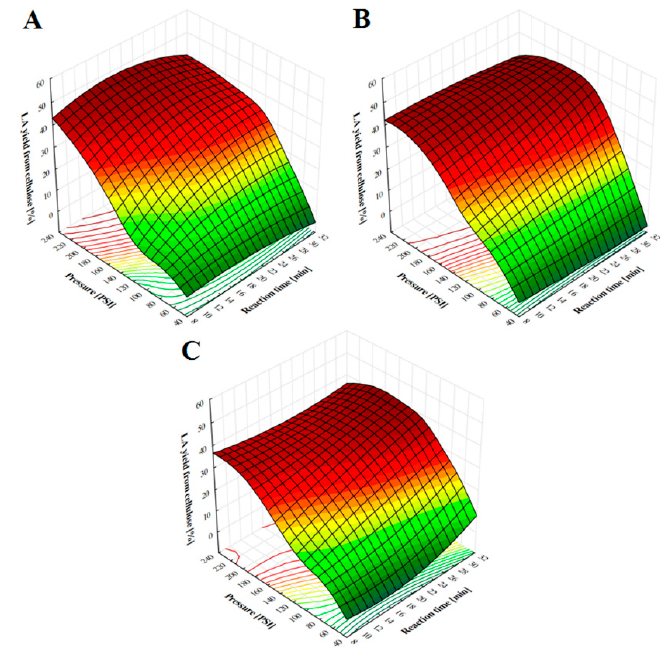
Figure 3. Response surface plot showing the effect of the interaction between pressure and reaction time of microwave-assisted conversion of pine chips on yield of production of levulinic acid from cellulose using sulfuric acid at a concentration of 2% with biomass content of 3.3% ( A ), 5% ( B ) and 10% ( C ).